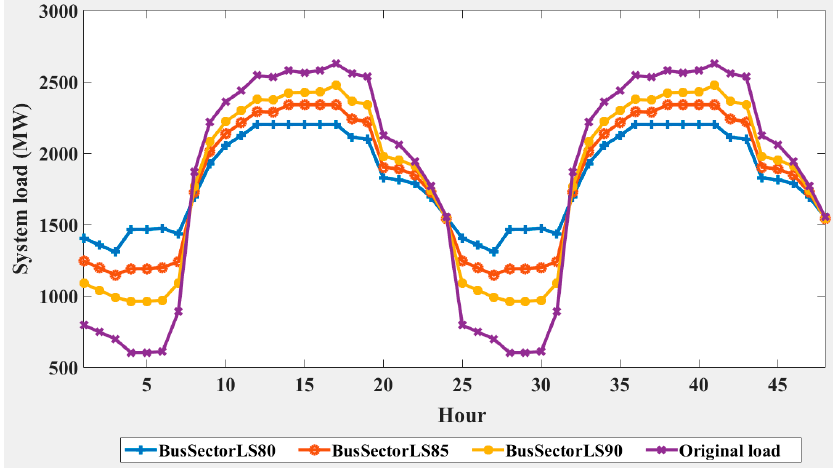
Figure 3. The 48-h system load profile for BusSectorLS80, BusSectorLS85, and BusSectorLS90.